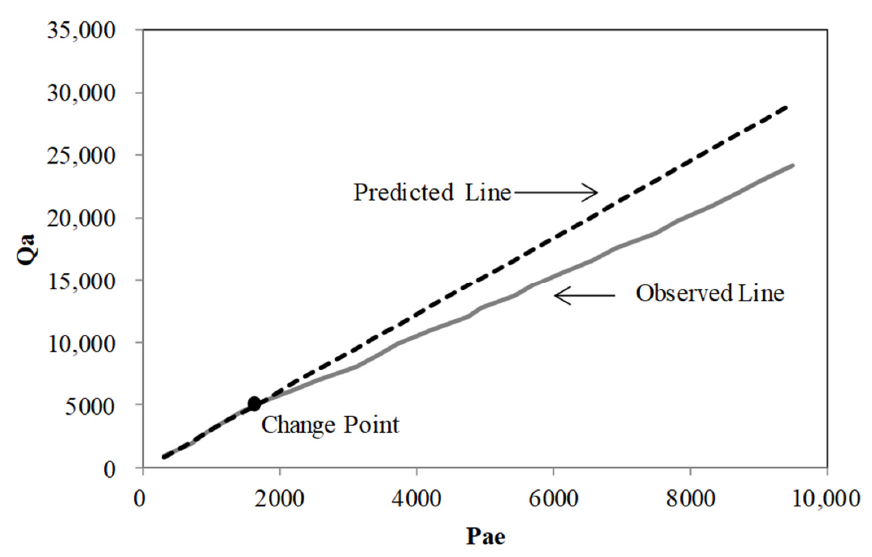
Figure 3. An example of modified double mass curve (MDMC) (unit: mm).